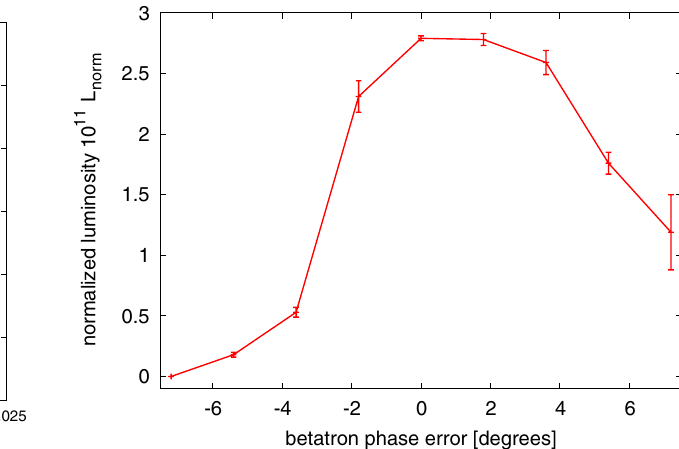
FIG. 9. (Color) Maximum normalized luminosity obtained dur- ing tune scans as a function of the betatron phase error between IP and electron